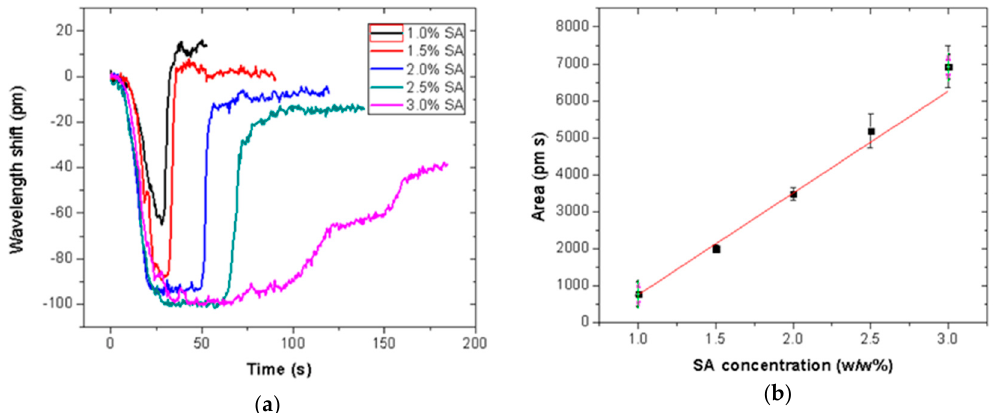
Figure 2. ( a ) Depiction of the wavelength shift in terms of time as SA w/w% increases; ( b ) Representation of the increase of area under the peak while the SA w/w% changes.